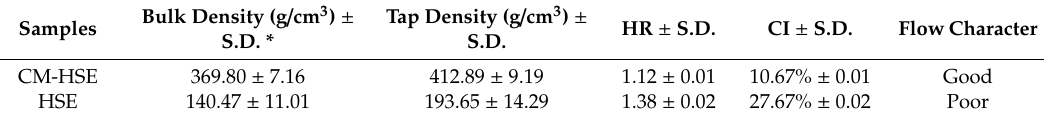
Table 3. Flow properties of CM-HSE